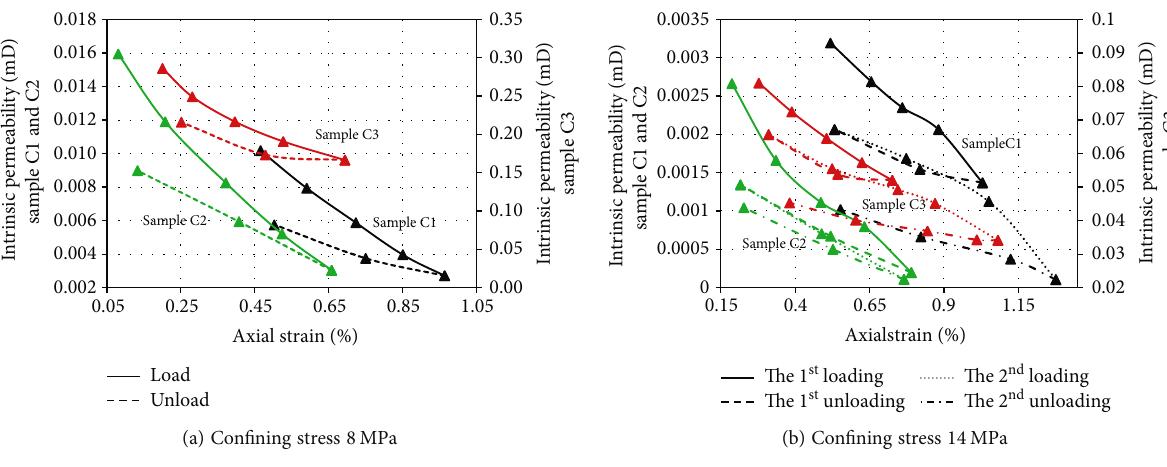
Figure 8: Coal intrinsic permeability changes with strain during cyclic axial